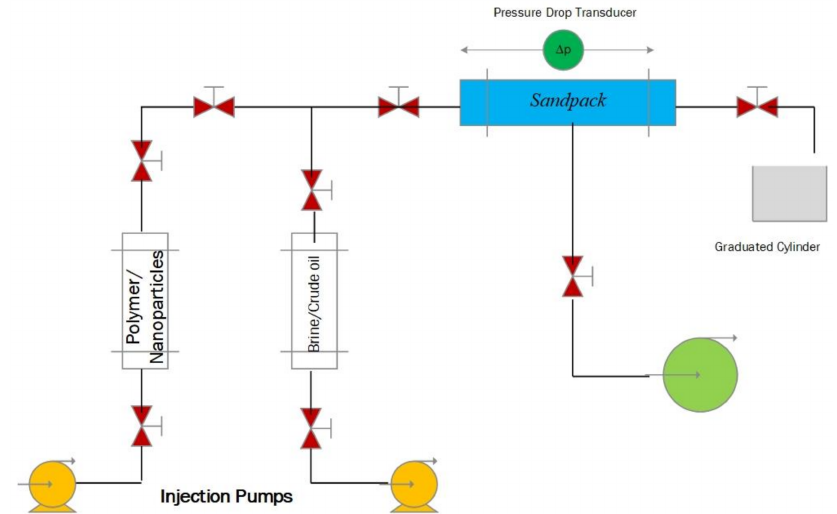
Figure 1. Experimental apparatus for sequential injection of water, polymer, and